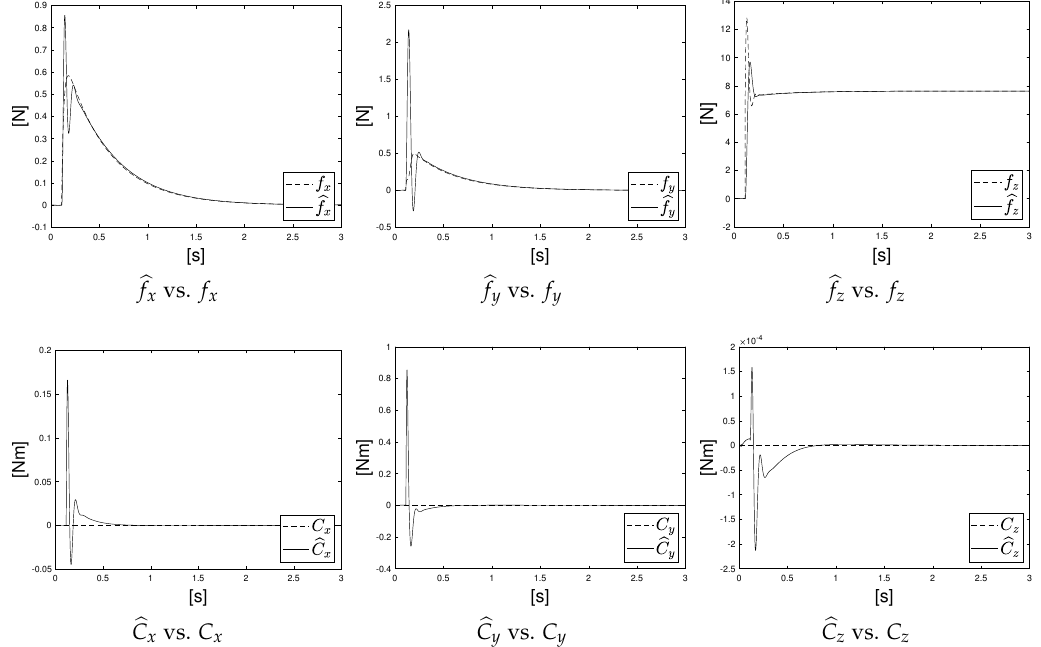
represented. In Figure 8, the force estimation error (cid:98) e f and the torque estimation error (cid:98) e C are shown. As it can be seen from the provided plots, a fast dynamic is achieved. A zero steady-state estimation error is achieved. Limited transition errors are shown. The obtained performance shows the capabilities of the algorithm to perform the estimation in the proposed scenario. The rms has been also computed for each force and torque error component to show the limited generalized mean estimation error.